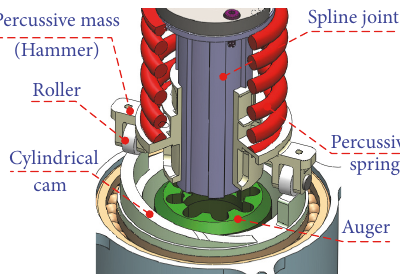
Figure 3: Three-dimensional configuration of the percussive mech-